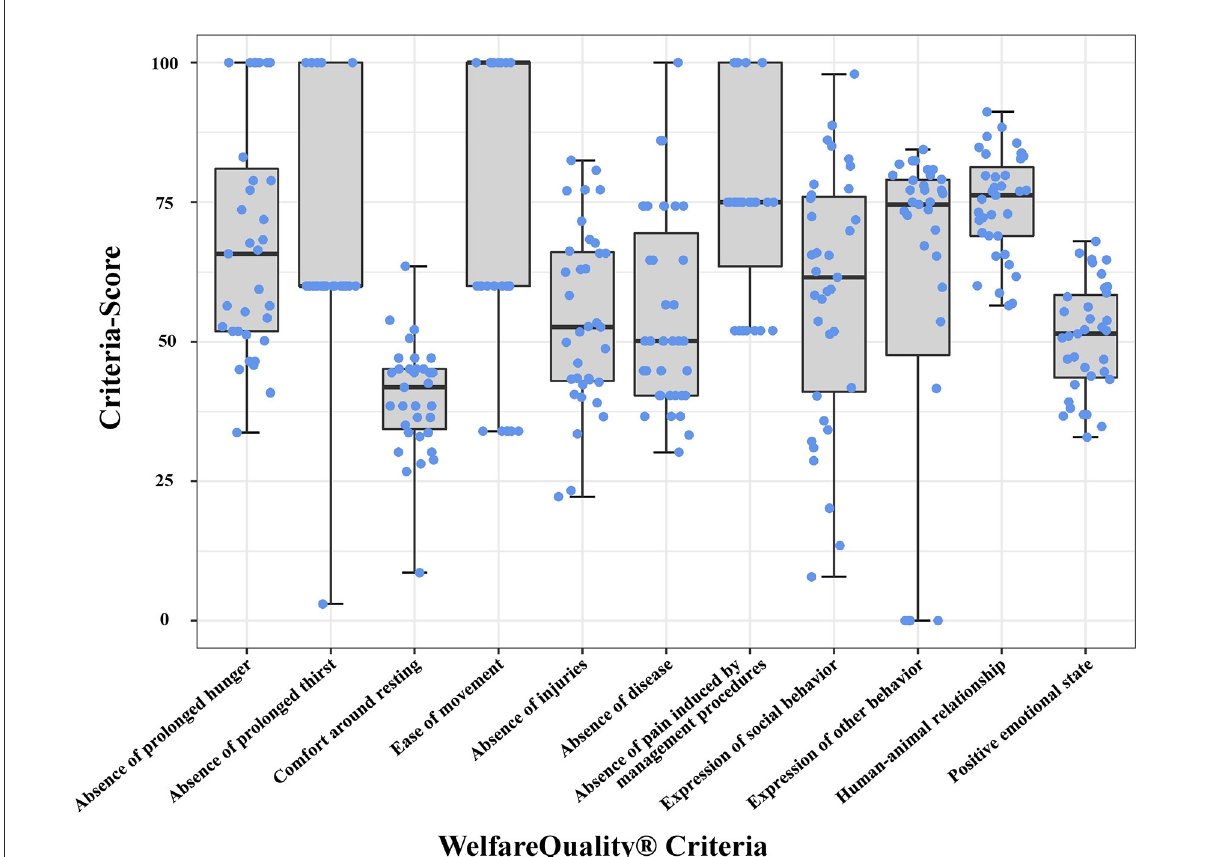
FIGURE1 Boxplots and jitter plots representing the WQ scores of 35 analyzed Swiss dairy farms in 11 calculable WQ criteria. Boxes represent the distribution of farm scores, whiskers display the range between the lowest and the highest criteria score observed and blue jitters show the individual farm scores. For the criterion thermal comfort, no measurement has yet been assigned in the WQ protocol; for reasons of clarity, a presentation has been omitted.